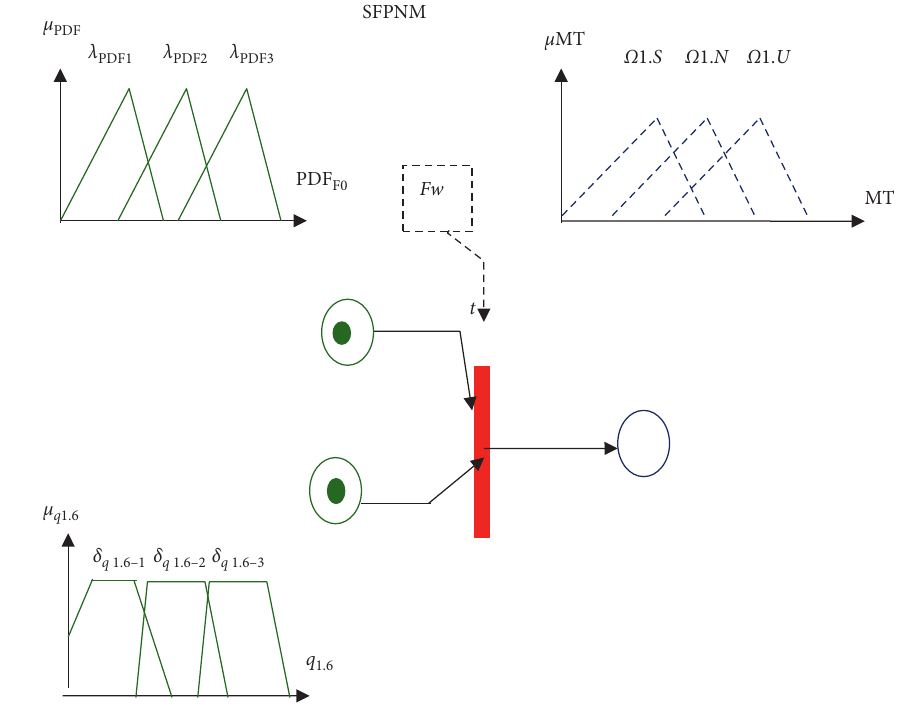
Figure 16: SFPNM of the studied railway network. Table 4: Linguistic variables associated with the